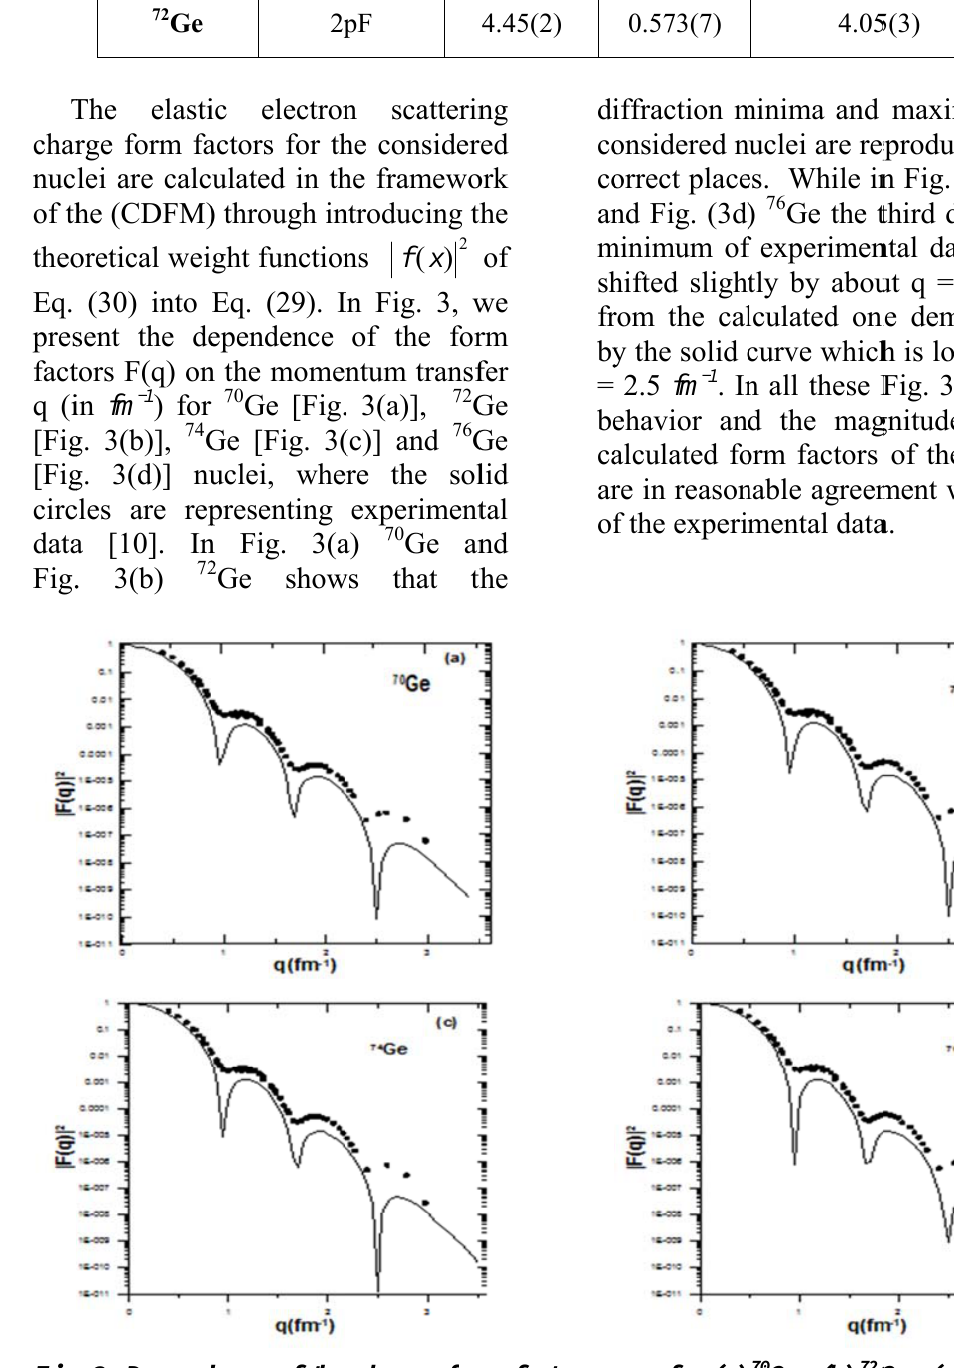
dence of the The solid experimenta